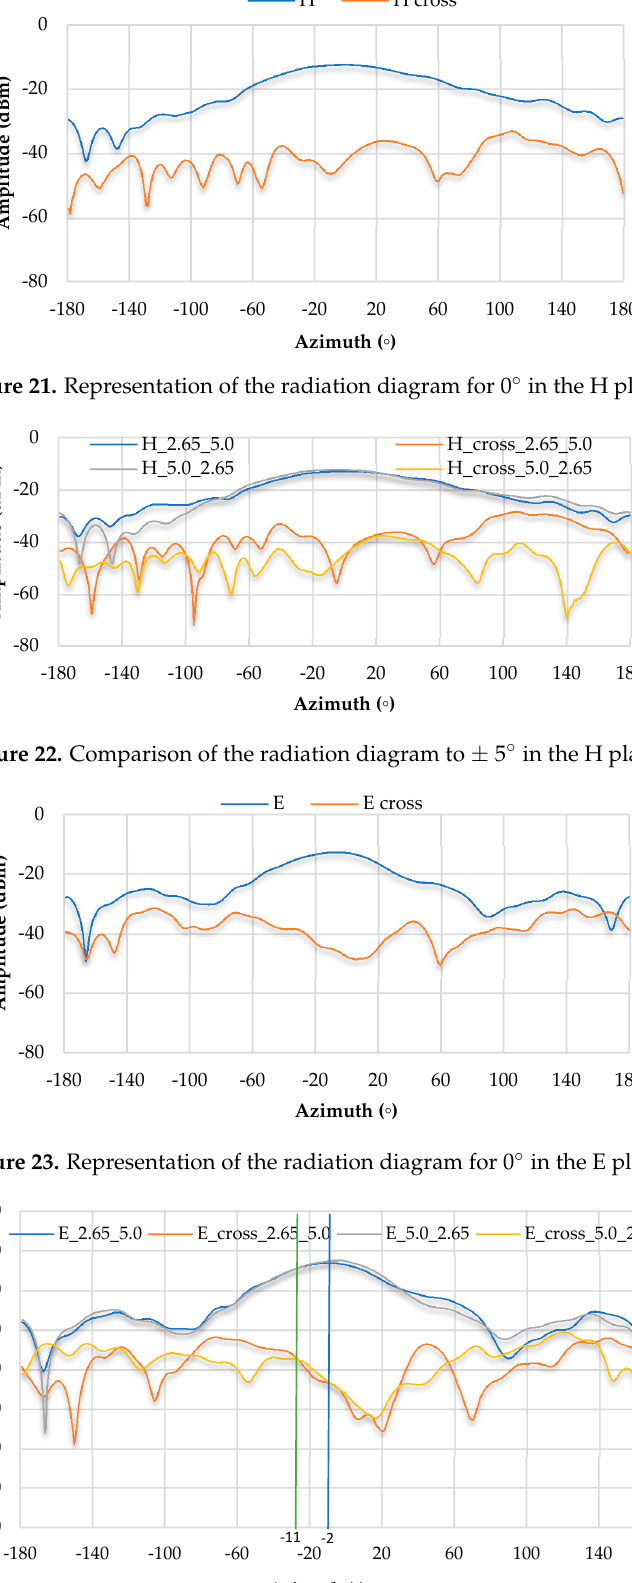
Figure 20. ( a ) Antenna in the anechoic chamber and ( b ) respective results of |S 11 | with a variation of 0 ± 5°.